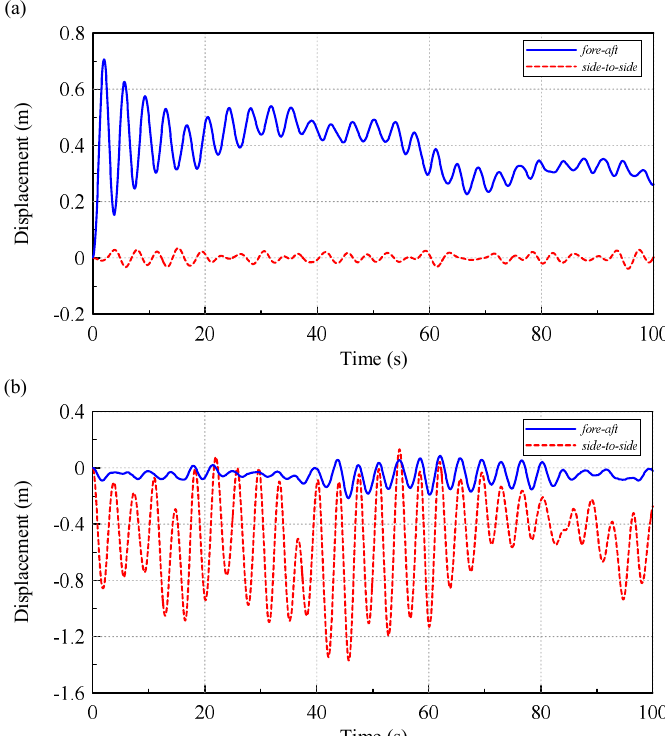
Figure 20. The displacement of the tower top in ( a ): DLC 1.2 condition; ( b ) DLC 6.2 condition.